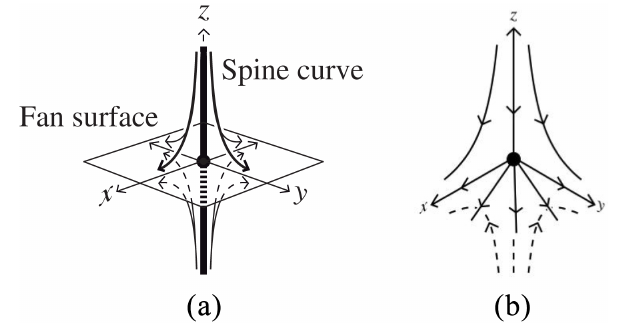
Figure 5. (a) The magnetic structure near a 3-D null point where the magnetic field vanishes. The spine is an isolated field line that approaches or recedes from the null point. (b) The field lines for a null point with magnetic components ( B x , B y , B z ) = ( x , y , − 2 z ).